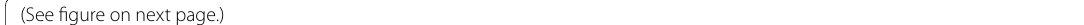
(See figure on next page.) Fig. 8 Ln changes in taxa promoted by sow feed (sows receiving (ABF) vs not (NMF) medicated feed; ln change and p ‑value < 0.05) at phylum, family and genus level in the microbiota of piglets. Positive values and negative values indicate higher and lower abundance, respectively, in piglets from ABF‑fed mothers. Taxa are sorted by level of significance (from higher to lower). Only taxa with relative abundances higher than 0.5% are included in the figure. The presented differences are based only on taxa detected in at least half of the animals per sampling. Figure created with the online open‑source tool Datawrapper (http:// dataw rapper.